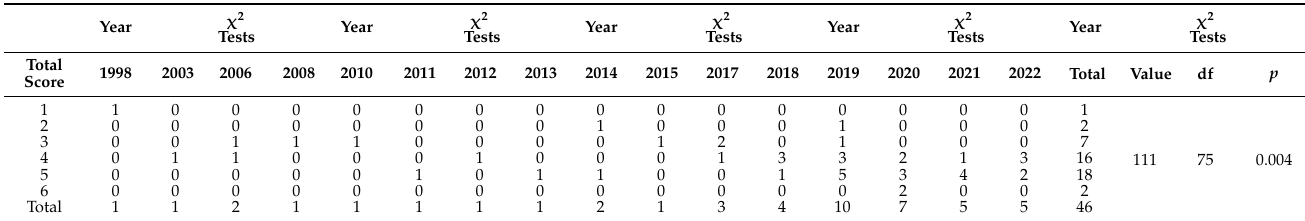
Table 6. Contingency Tables; Total Score and